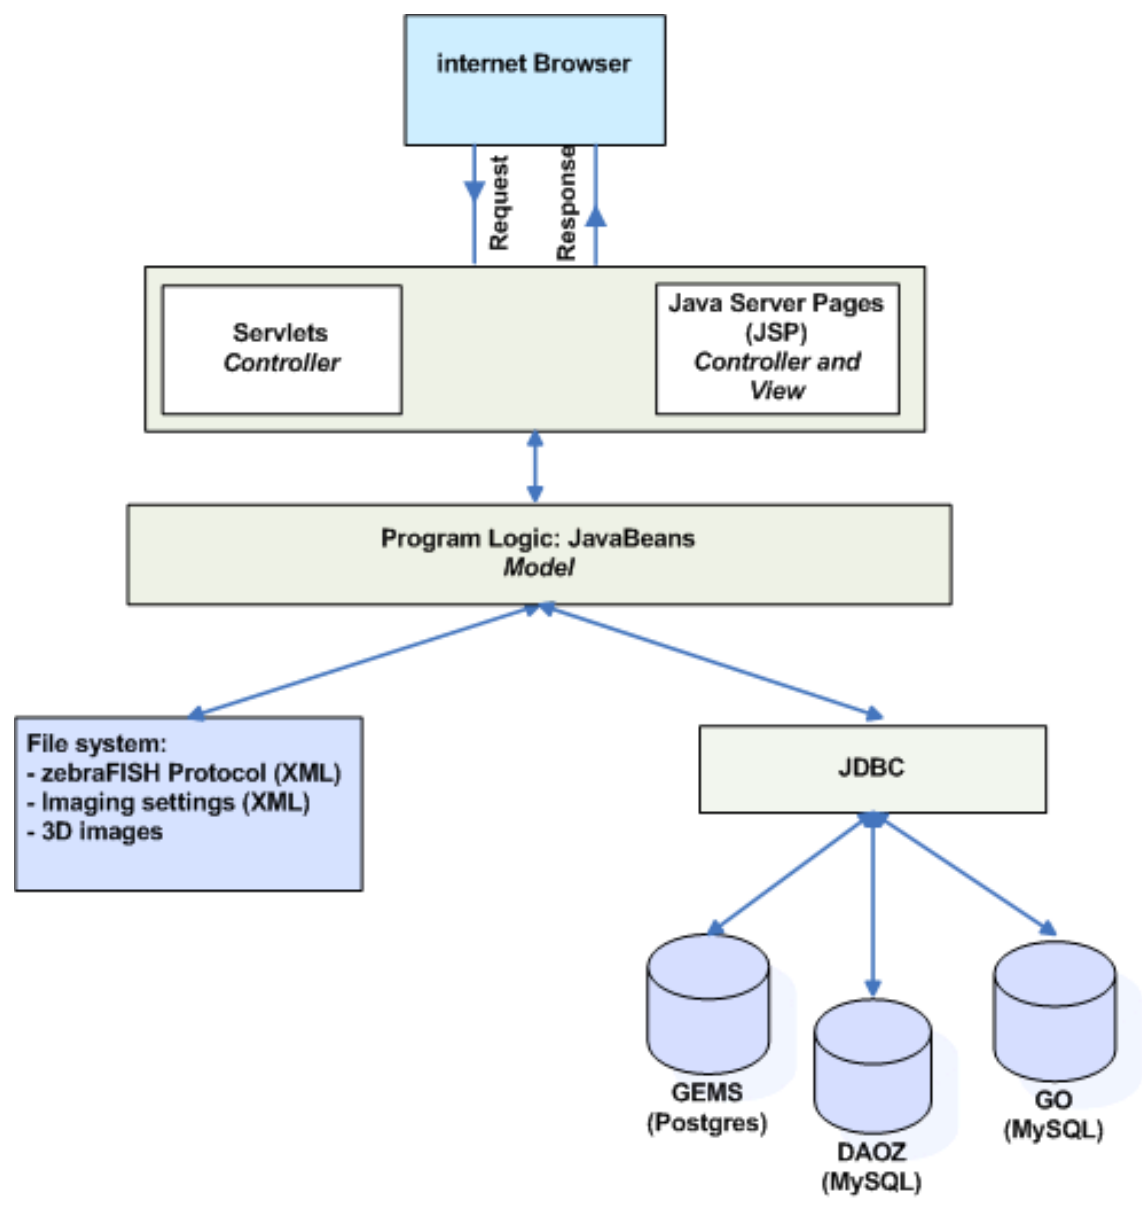
Figure 3: The Model-View – Controller architecture of the